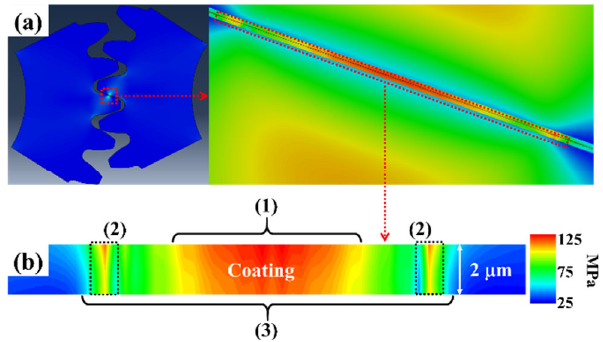
Fig. 6 Von Mises stress distribution of the gear set (a) at the pitch point and (b) of the coating with an enlarged view. In the enlarged view, three notable stress regions were found: (1) the center of the surface, (2) the end of contact, and (3) the overall contact area.